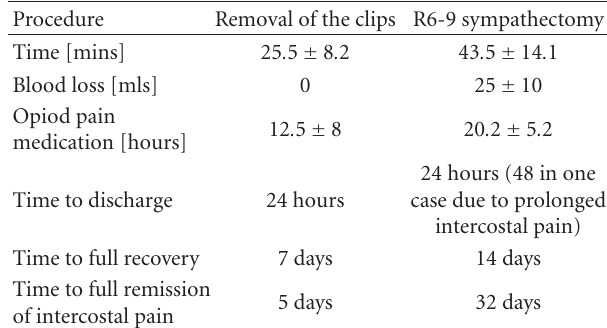
Table 2: Surgical characteristics of the